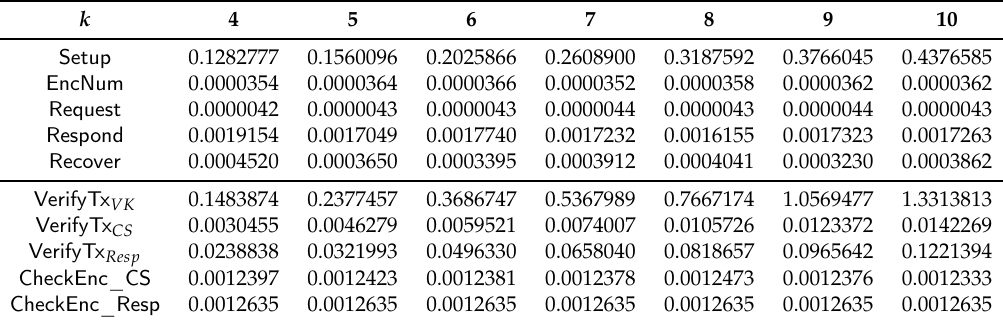
Table 2. Performance of algorithms.